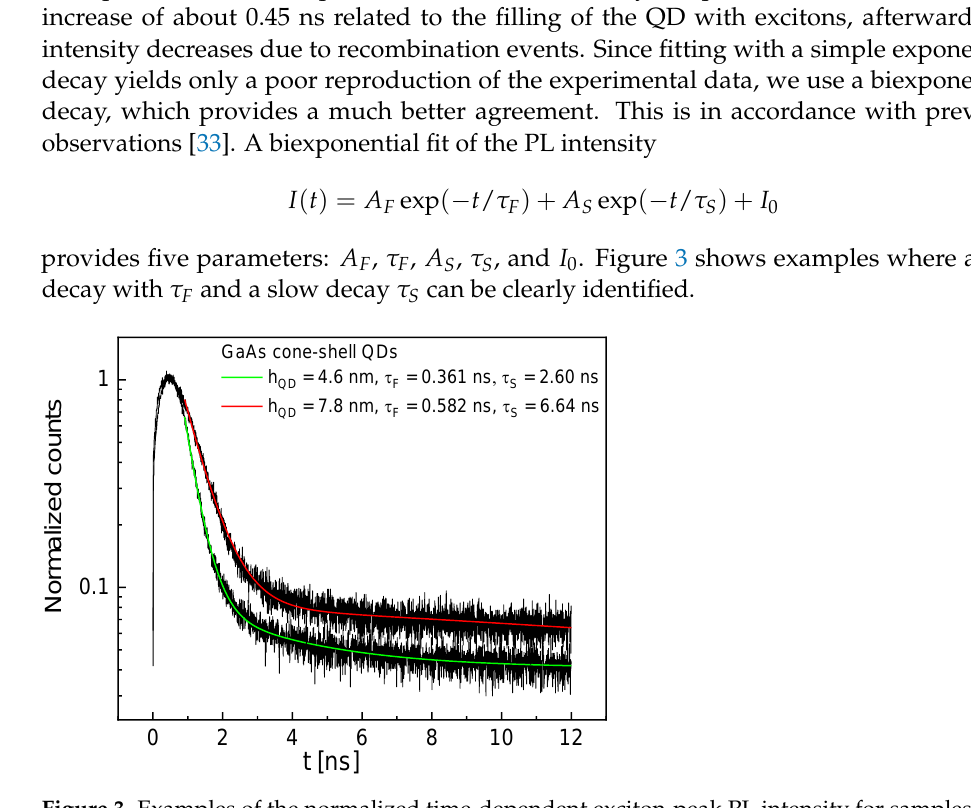
Figure 3. Examples of the normalized time-dependent exciton-peak PL intensity for samples with h QD = 4.6 nm ( d F = 0.28 m) and h QD = 7.8 nm ( d F = 0.45 nm). Fit results assuming a biexponential decay with a fast process τ F and a slow process τ S are also